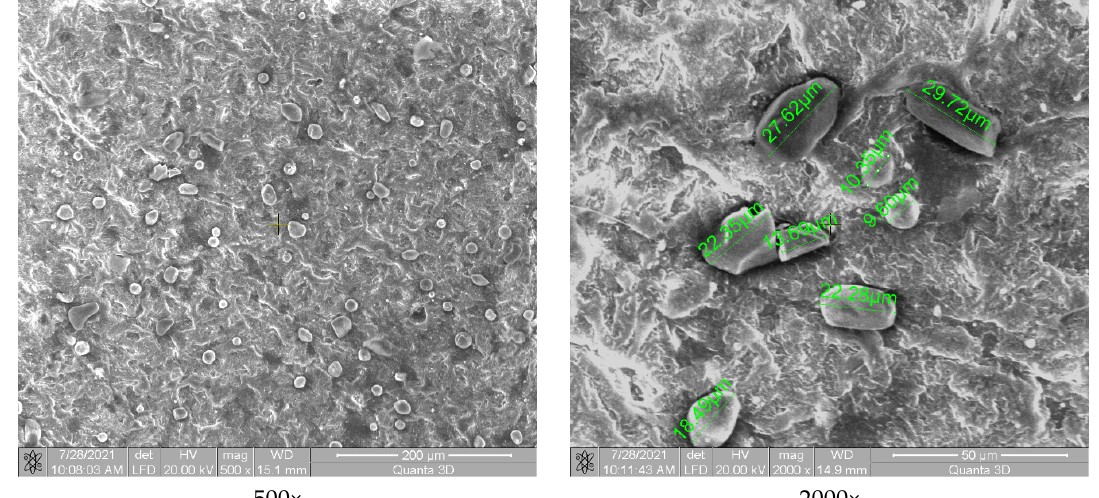
Figure 4. SEM analysis of the P6–6420–9 passes samples.